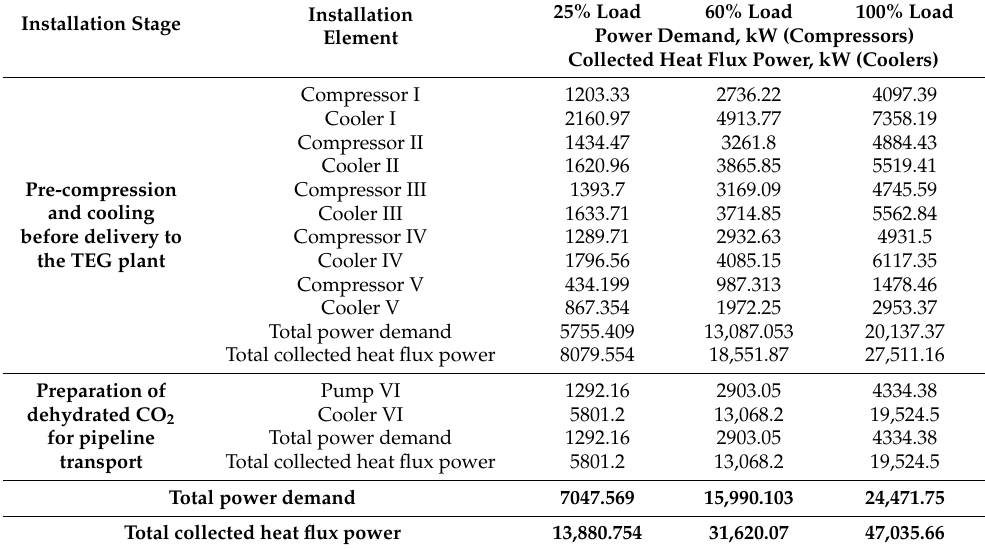
Table 9. Balance of energy required to power the compression and dehydration plant and energy of the heat flux collected.